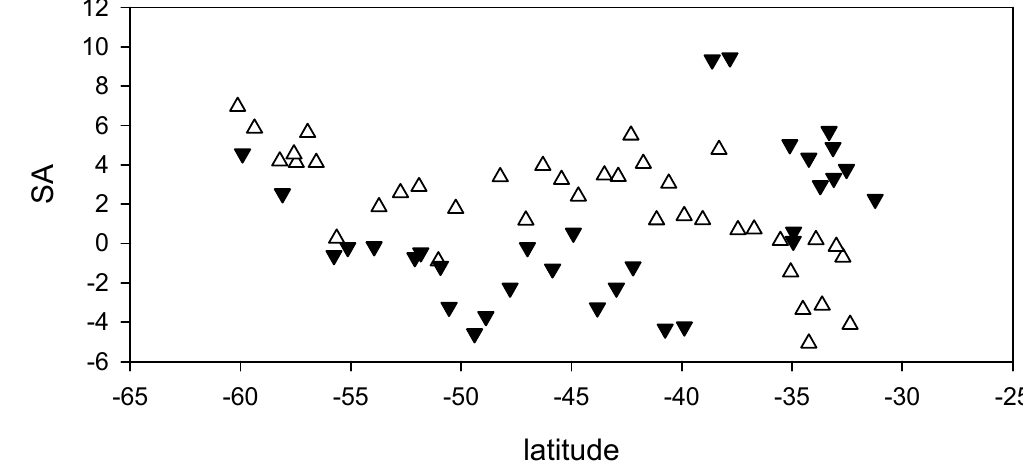
Figure 8. Distribution of SA values along the southward (solid triangles) and northward (open triangles) tracks of the 27th Chinese Antarctic Research Expedition.